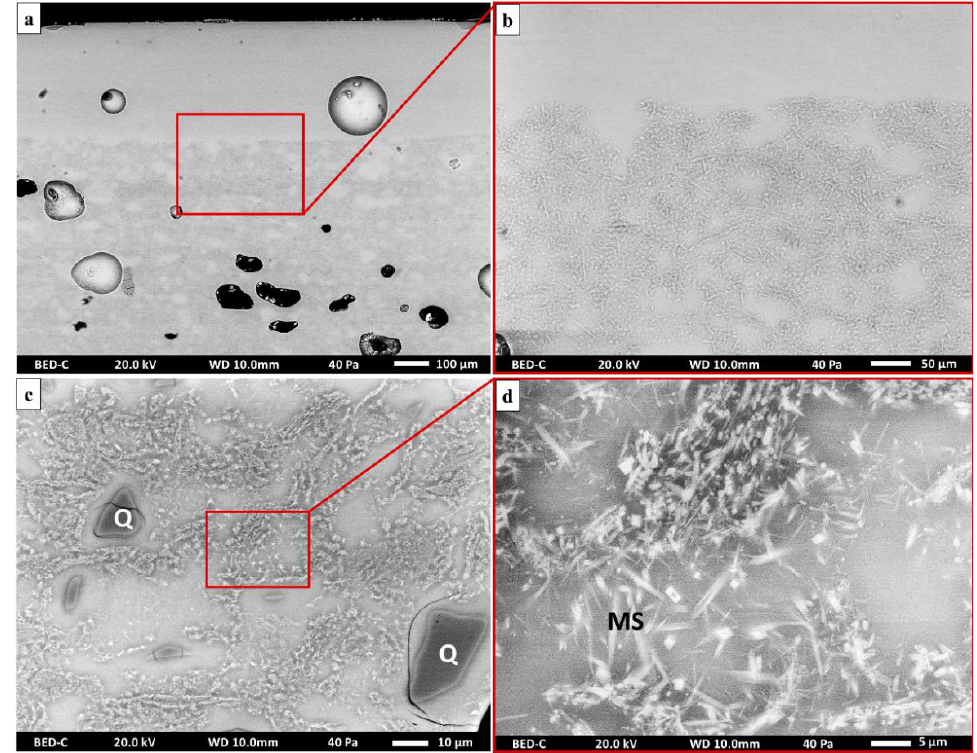
Figure 4. SEM backscattered electron images of the porcelain body ( a , b ); the presence of secondary mullite crystals (MS) and quartz (Q) can be noted ( c , d ).